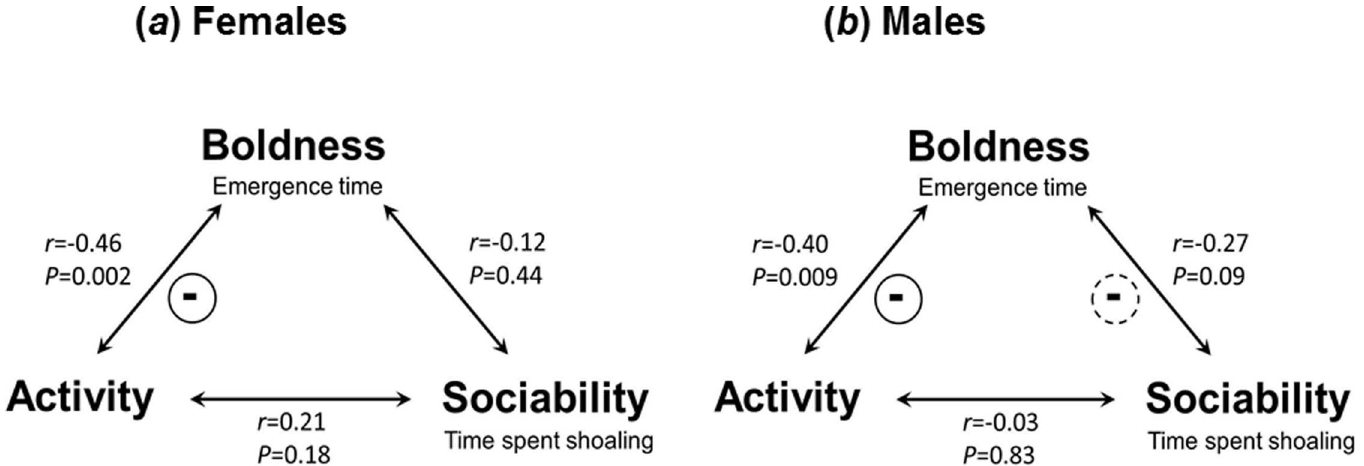
Fig 2. Behavioral syndrome structures of focal ( a ) females and ( b ) males, assessed via Pearson correlations between the three behavioral parameters (boldness, activity and sociability/shoaling